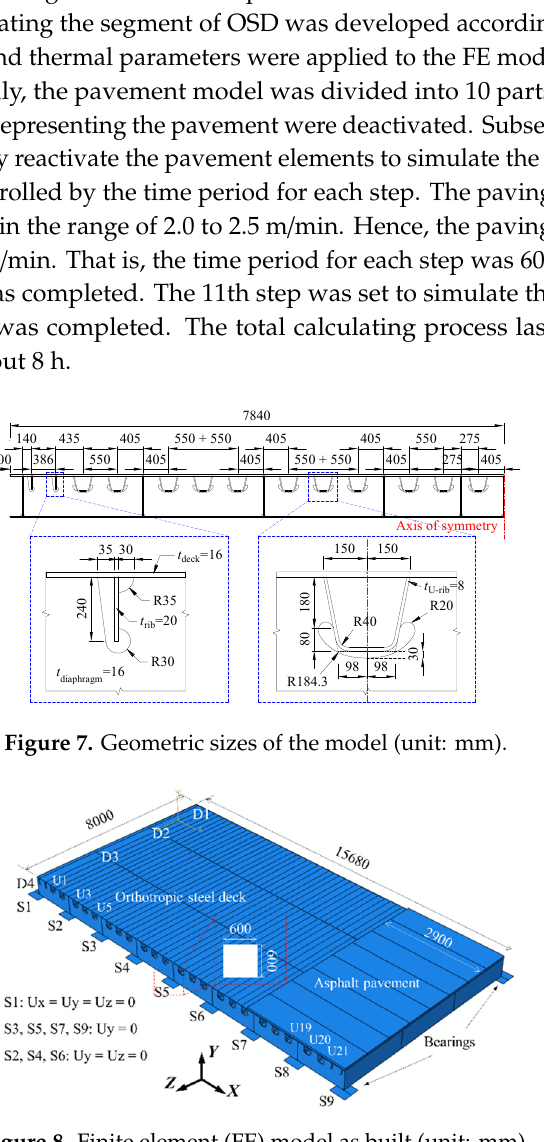
Figure 8. Finite element (FE) model as built (unit: mm).